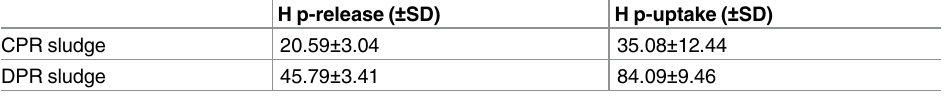
H—heat outputs; SD—standard